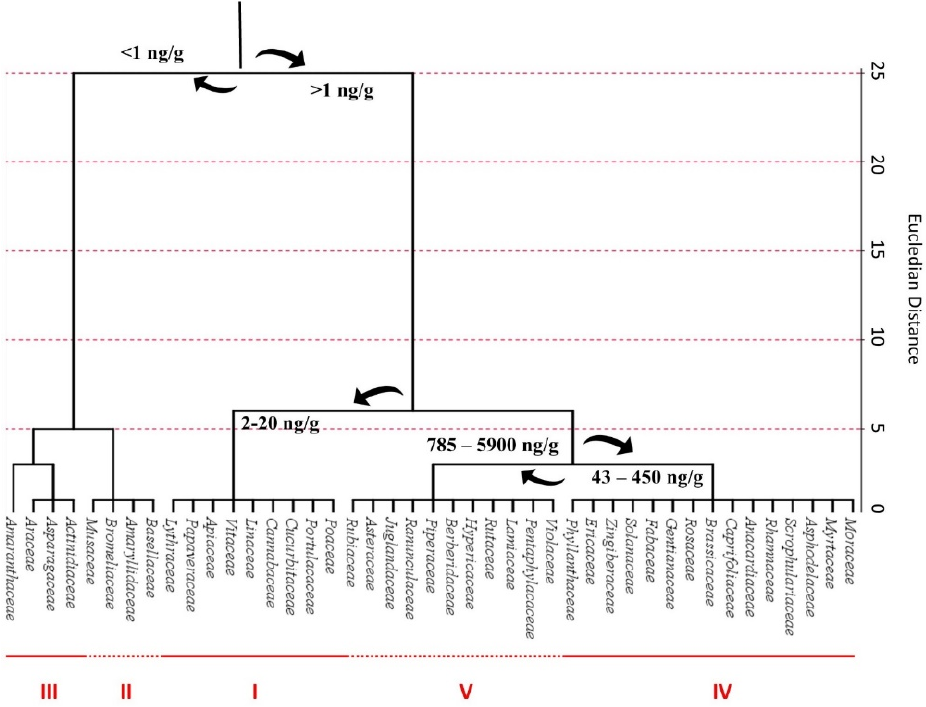
Figure 11. Cluster distribution of melatonin within plant families, according to previously published data [38,115,129–173]. Euclidean distances were calculated with centroid method. Data were expressed as ng melatonin per g of FW. Statistical analysis and graphical representation were made using SPSS v. 24 software.